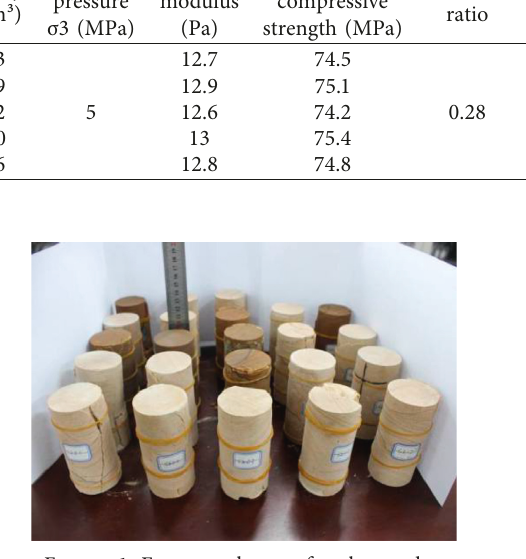
Figure 1: Fracture photos of rock samples.